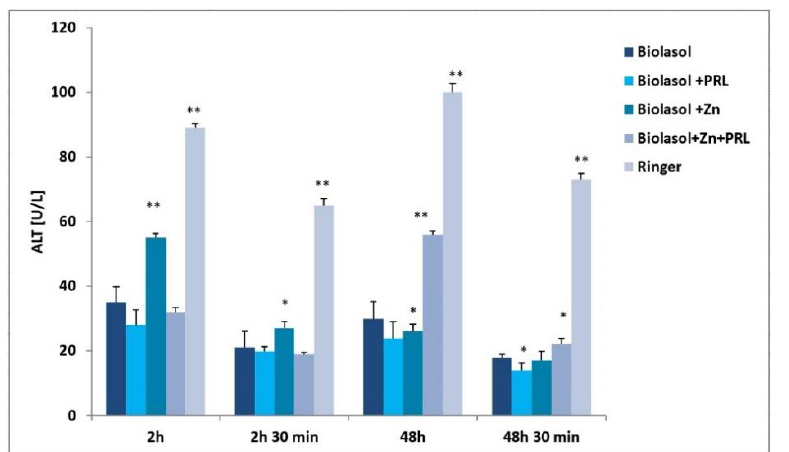
Figure 1. ALT activity in the collected perfusates and reperfusates in model of storing isolated porcine kidneys. The values are expressed as mean ± SEM. Data were analysed by one-way ANOVA and Bonferroni post hoc tests; n = 10; * p < 0.05; ** p < 0.01 compared to the control group (Biolasol).